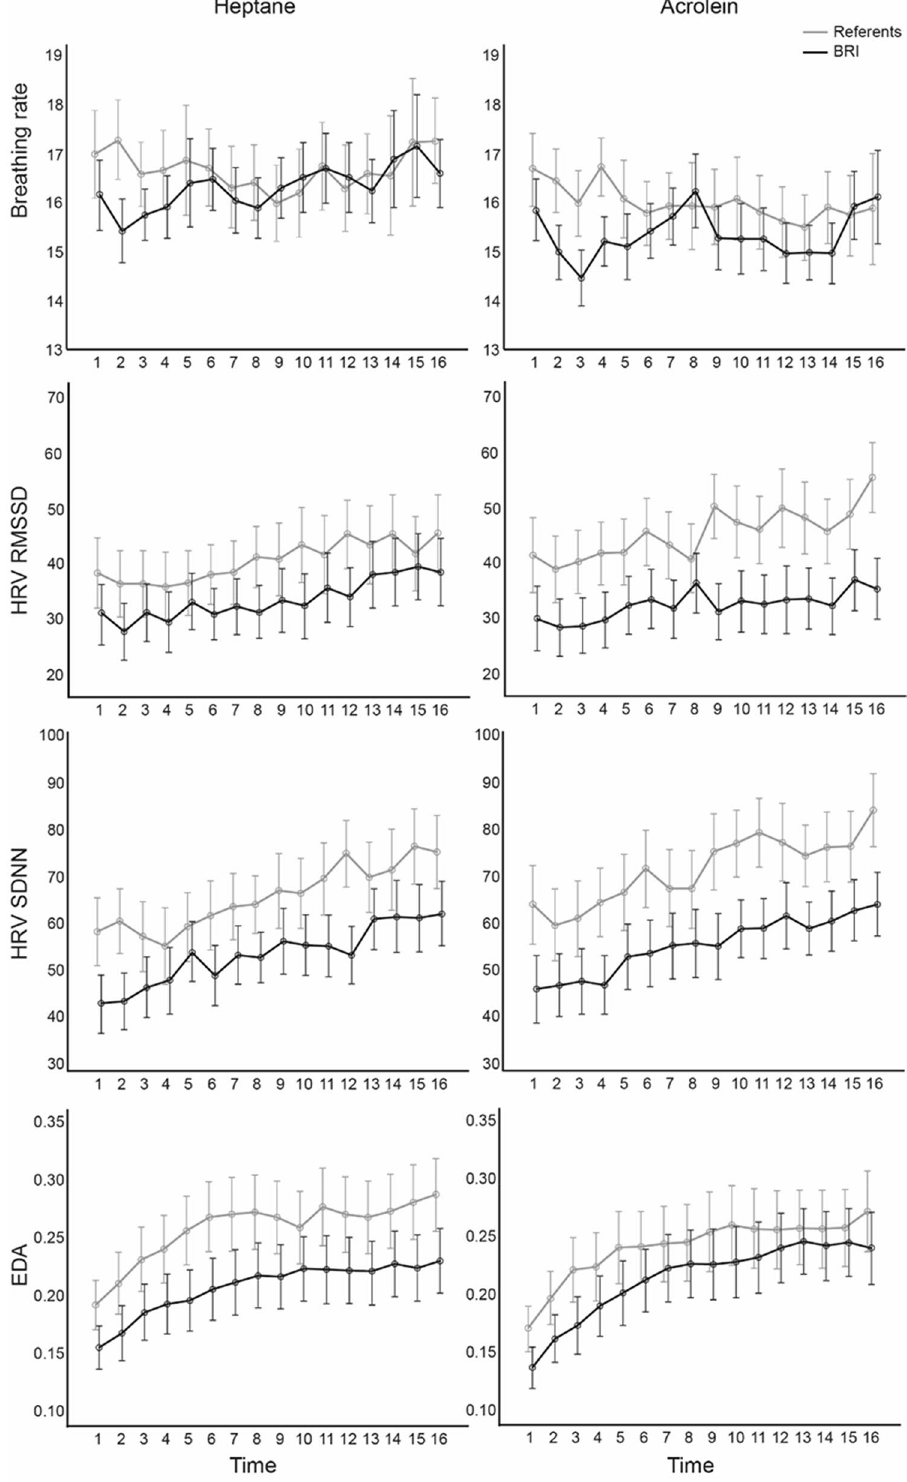
Figure 2. Estimated marginal means of breathing rate, RMSSD and SDNN measures of heart rate variability and electrodermal activity (EDA) over time in BRS cases and referents when exposed to Heptane and masked